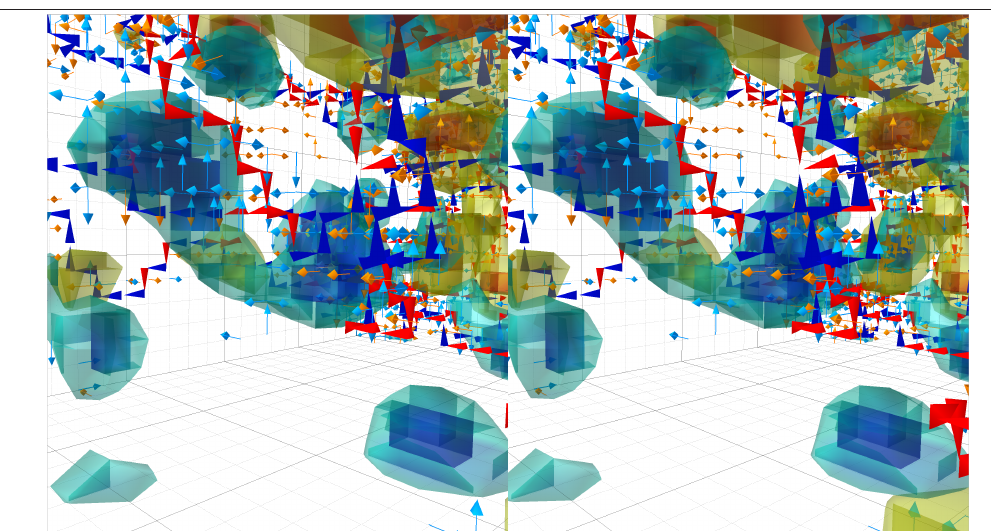
Figure 5. Stereoscopic image illustrating the correlation of topological charge density in the gluon field with the positions of centre vortices. Positive charge density is rendered red through yellow and negative charge density is rendered blue through